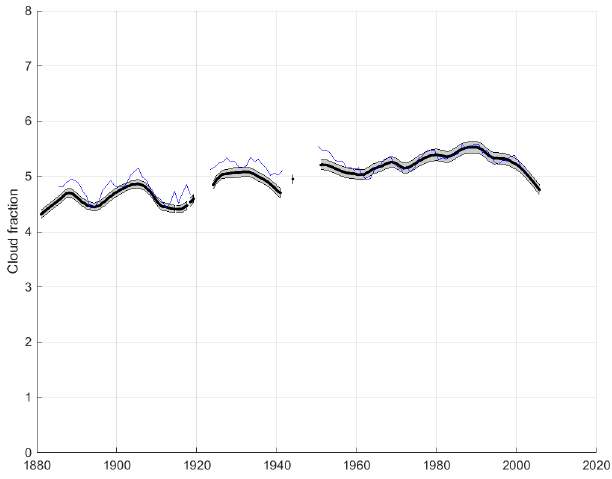
Figure 5. Cloud fraction during